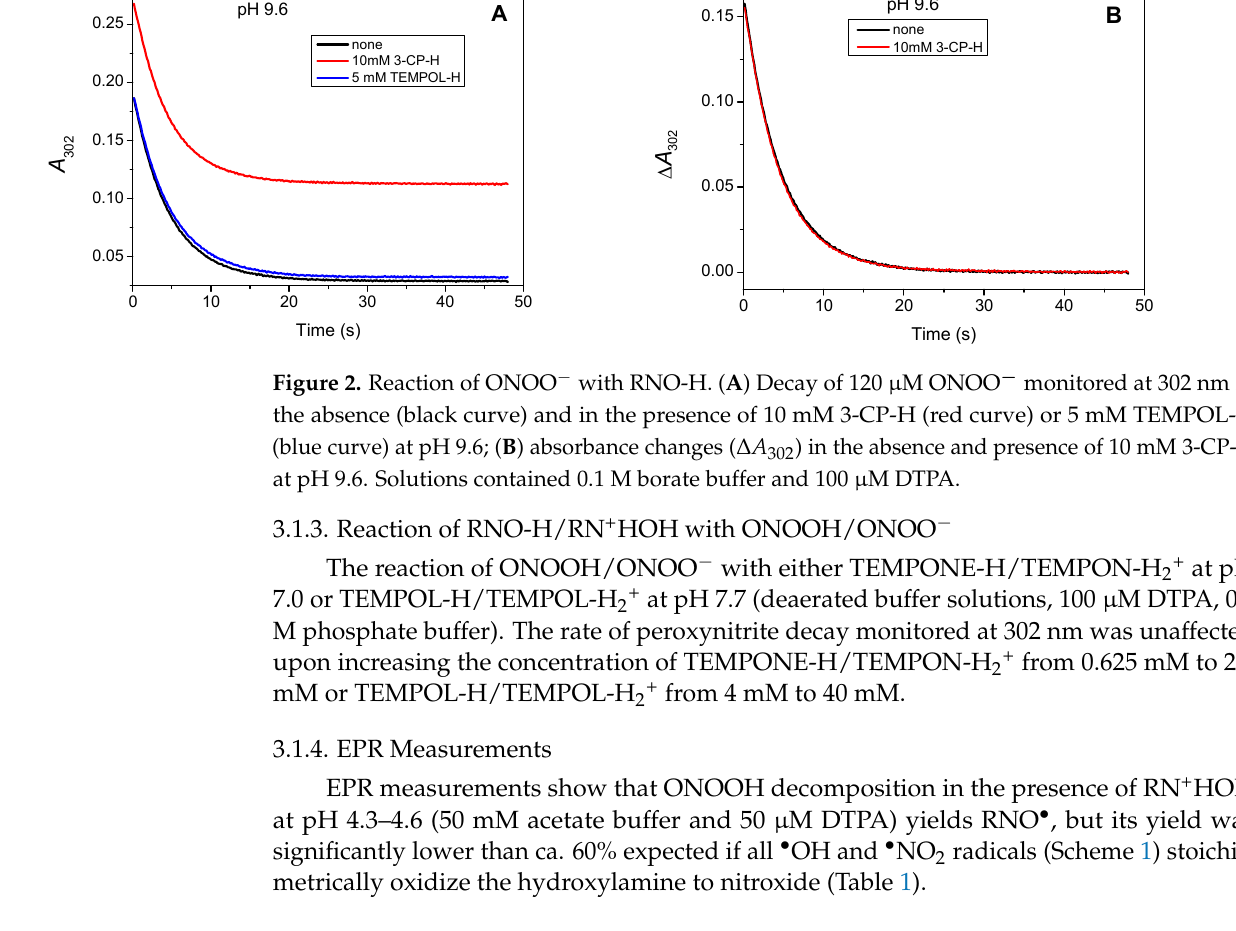
Table 1. Nitroxide yield monitored upon reaction of ONOOH with RNO-H 2+ at pH 4.3–4.6 (50 mM acetate buffer, 50 μ M DTPA).